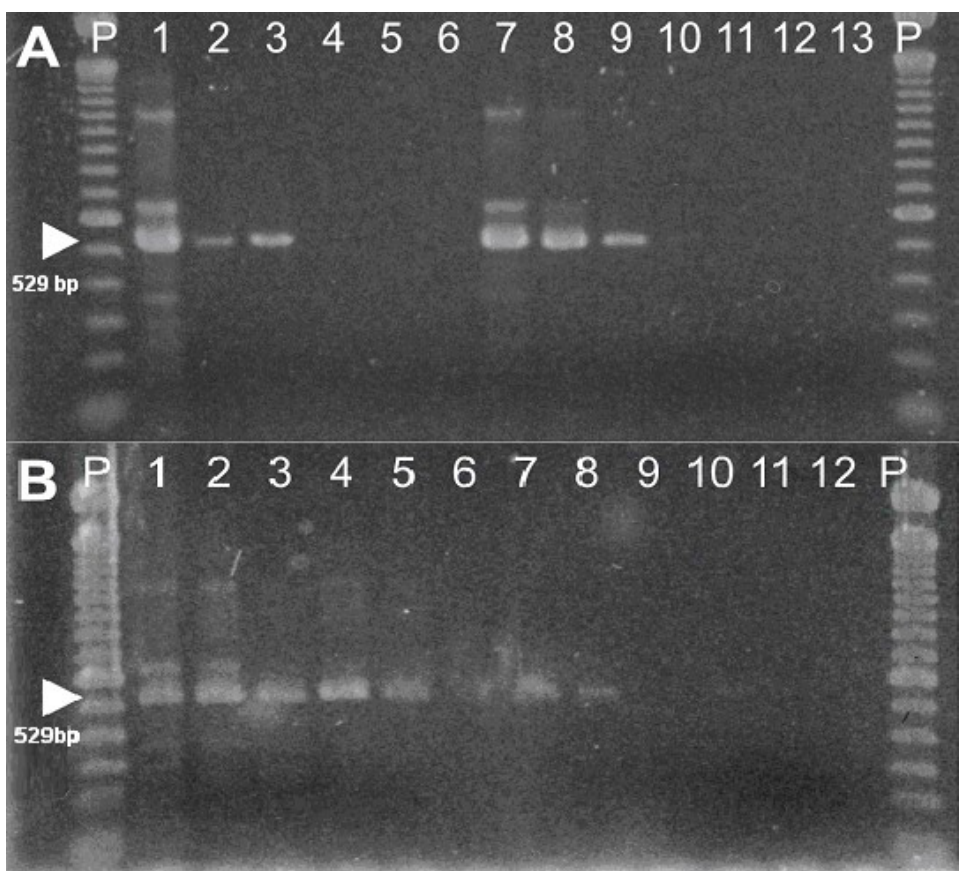
Figure 1: Polymerase chain reaction (PCR) for detection of Toxoplasma gondii DNA in sera samples contaminated with 10 3 , 10 2 , 10 1 , and 10 0 tachyzoites. Botucatu, 2005. A - Lanes: P - 100bp DNA-Ladder (Gibco ® ), molecular weight marker; 1 - positive control (AS28 strain); 2 - serum with 10 3 tachyzoites (protocol 1); 3 - serum with 10 2 tachyzoites (protocol 1); 4 - serum with 10 1 tachyzoites (protocol 1); 5 - serum with 10 0 tachyzoites (protocol 1); 6 - serum without tachyzoites; 7 - serum with 10 3 tachyzoites (protocol 2); 8 - serum with 10 2 tachyzoites (protocol 2); 9 - serum with 10 1 tachyzoites (protocol 2); 10 - serum with 10 0 tachyzoites (protocol 2); 11 - serum without tachyzoites; 12 - Tris-NaCl-EDTA (TNE); 13 - ultrapure water (mix-PCR control). B - Lanes: P - 100bp DNA-Ladder (Gibco ® ), molecular weight marker; 1 - positive control (AS28 strain); 2 - serum with 10 3 tachyzoites (protocol 3); 3 - serum with 10 2 tachyzoites (protocol 3); 4 - serum with 10 1 tachyzoites (protocol 3); 5 - serum with 10 0 tachyzoites (protocol 3); 6 - serum without tachyzoites; 7 - serum with 400 tachyzoites (protocol 2); 8 - serum with 40 tachyzoites (protocol 2); 9 - serum with 4 tachyzoites (protocol 2); 10 - serum with 10 0 tachyzoite (protocol 2); 11 - serum without tachyzoites; 12 - ultrapure water (mix-PCR